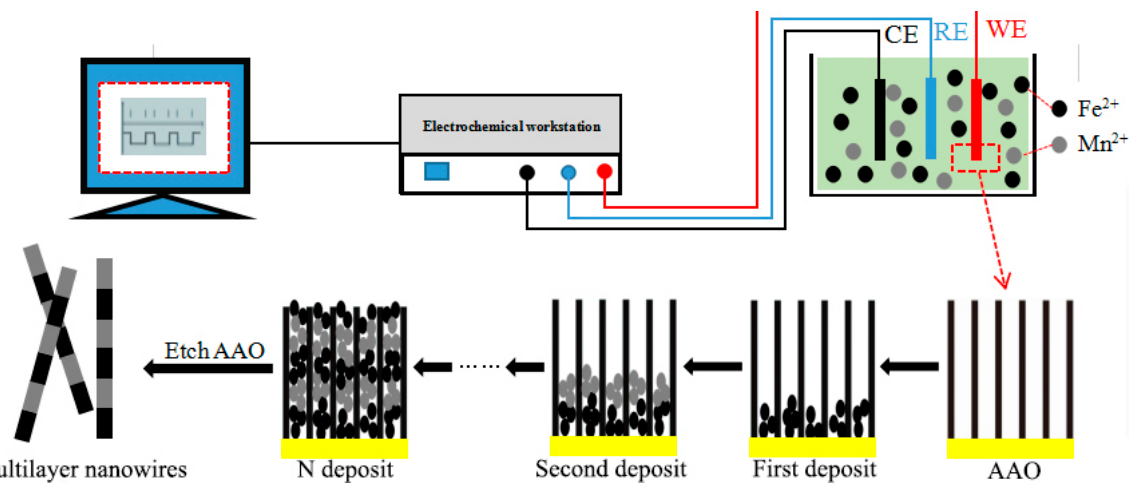
Figure 1. Schematic illustration of deposition Fe/Mn multilayer NWs array.